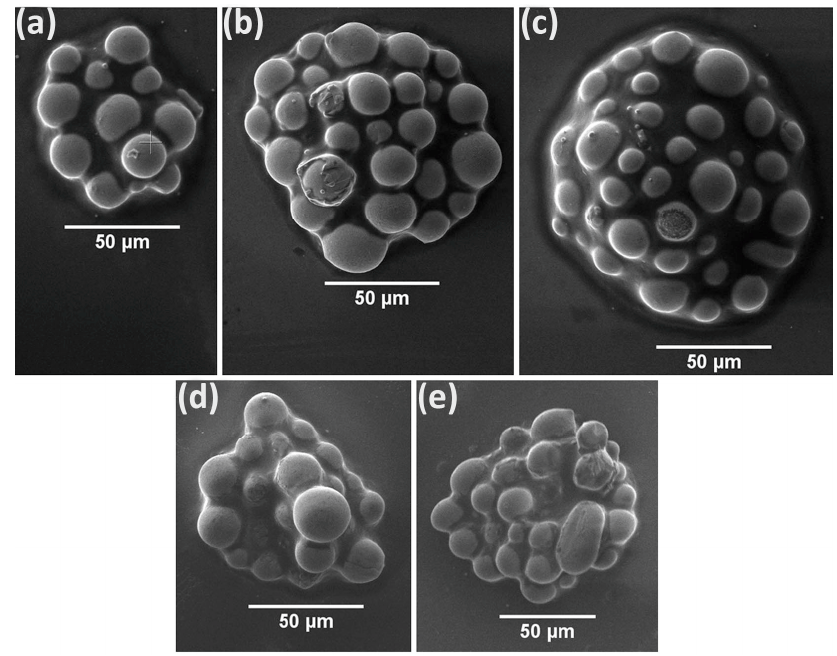
Figure 5. SEM characterization of laser-printed solder bumps post-oven-curing. ( a – c ) on Si, 1.3 J/cm 2 , 1.4 J/cm 2 , 1.6 J/cm 2 , respectively. ( d , e ) on PI substrate, 1.3 J/cm 2 , 1.4 J/cm 2 , respectively.